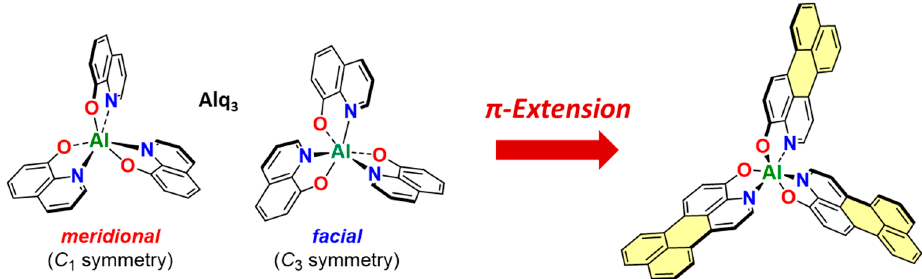
Figure 1. Chemical structures of Alq 3 stereoisomers and of a π -extended Alq 3 that contains an azaperylene unit in each ligand.